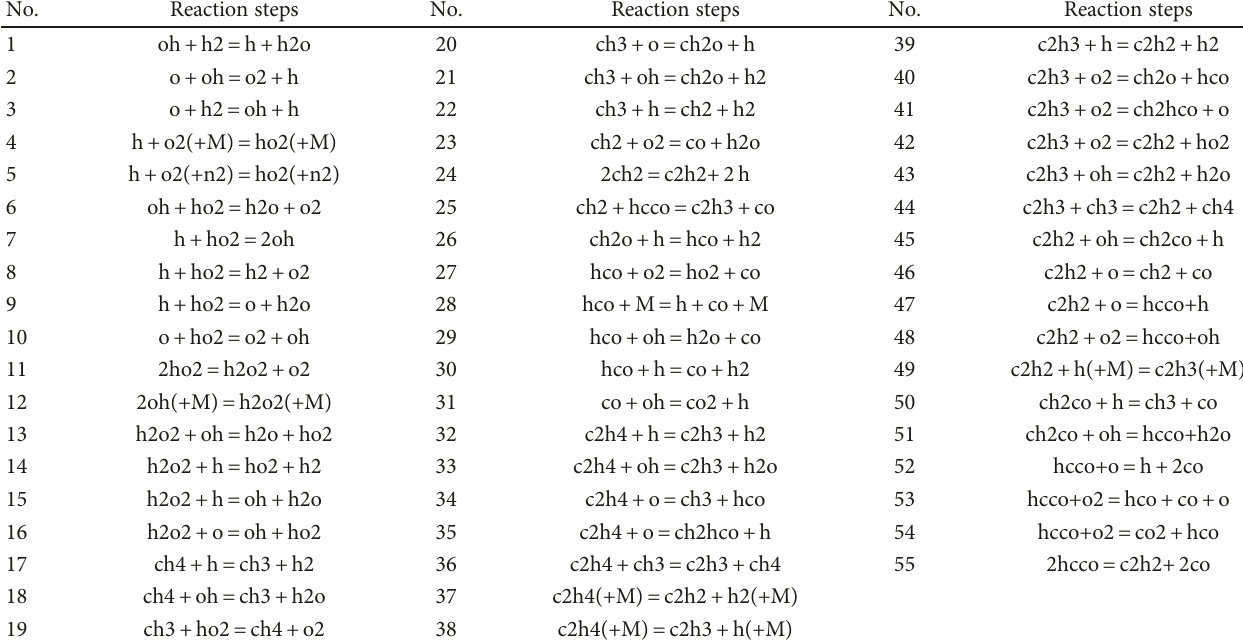
Table 3: Elementary reactions in reduced